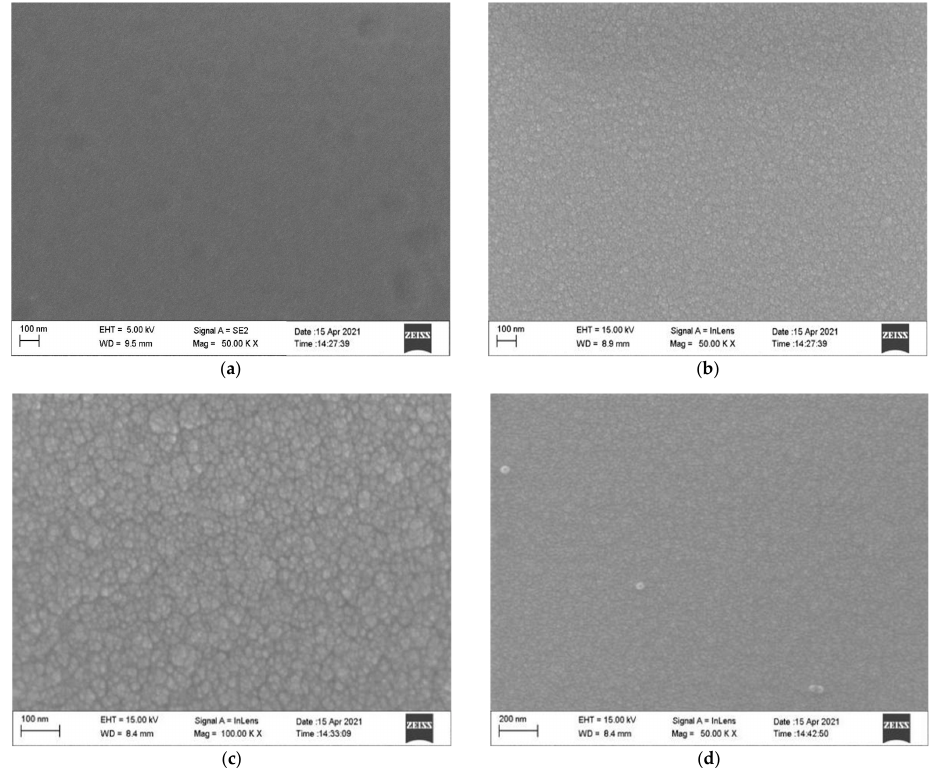
Figure 7. SEM image of functional film surface: ( a ) Al 2 O 3 thin films surface; ( b ) NiCr thin films surface; ( c ) NiSi thin films surface; ( d ) SiO 2 thin films surface.